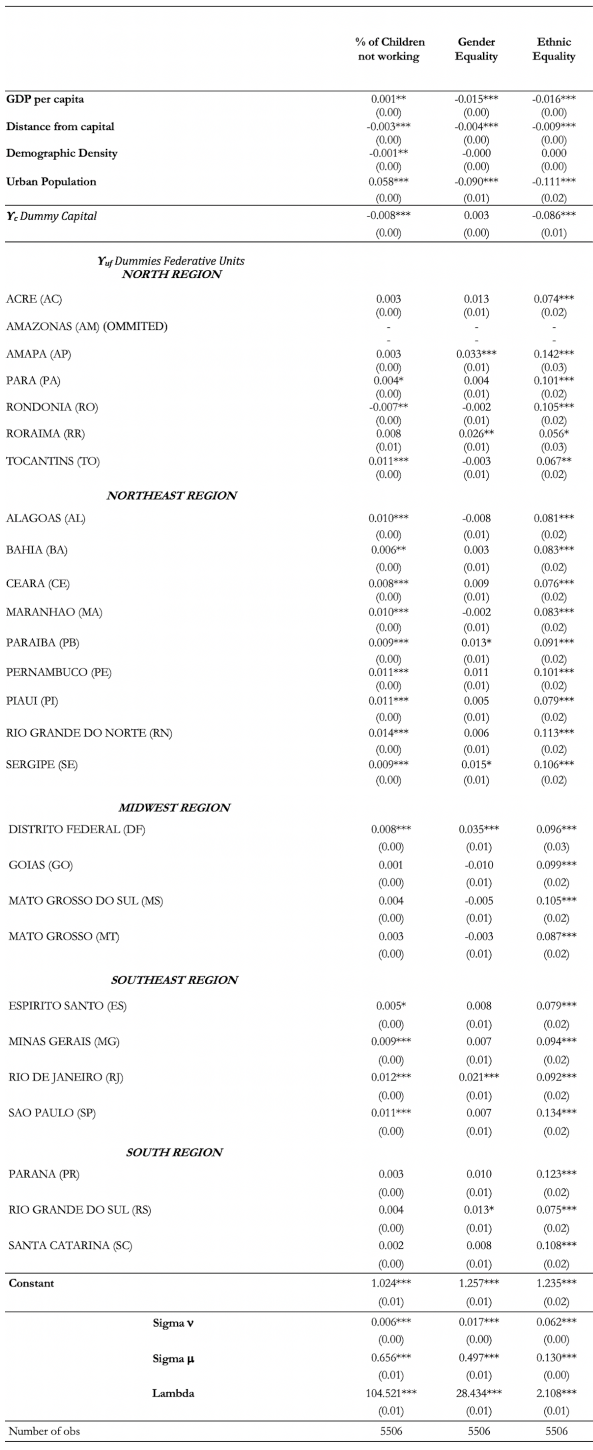
Table 9: Labor Standards Regressions MODEL